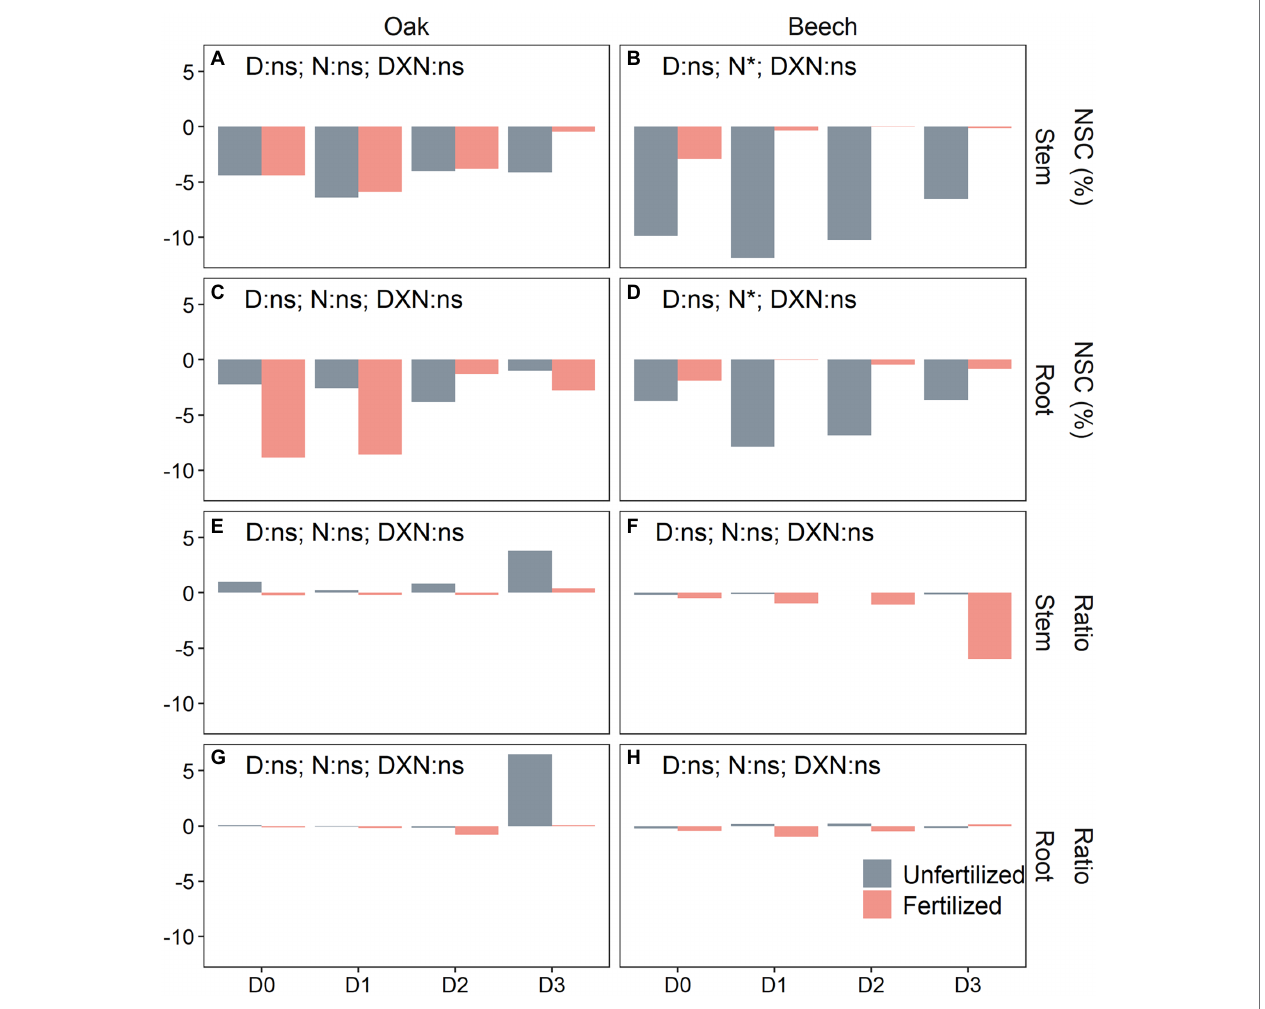
FIGURE 4 | Over-winter changes in non-structural carbohydrate (NSC) concentrations (A–D) (post-winter values minus pre-winter values) and the sugar/starch ratio (E–H) in stem (A,B,E,F) and root (C,D,G,H) of oak ( Quercus petraea ) and beech ( Fagus sylvatica ) saplings treated with four drought durations during the previous growing season. D0 (watering weekly), D1 (watering biweekly), D2 (watering monthly), and D3 (watering bimonthly) represent the drought